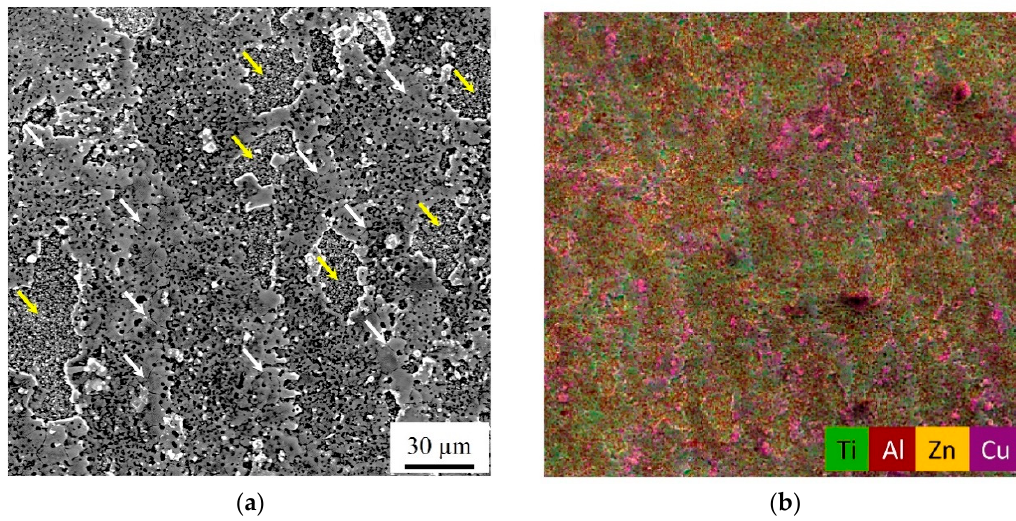
Figure 5. The surface of Al 2 O 3 ‐ 40 vol.% TiC composite after electrical discharge machining: ( a ) image obtained on SEM; ( b ) (Energy ‐ dispersive X ‐ ray spectroscopy) EDX map of the surface.